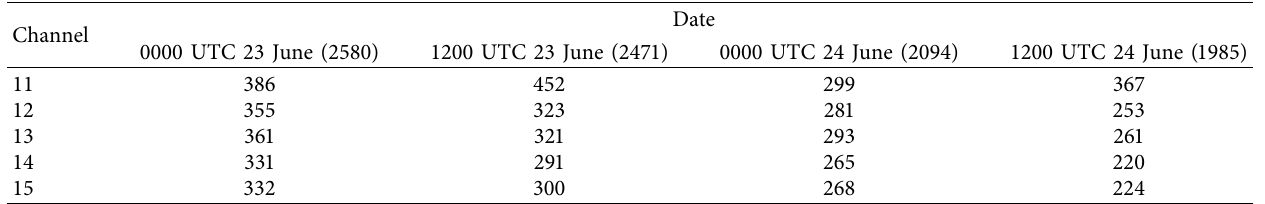
The values in the brackets represent the total number of observations over the model domain in the AL and DY